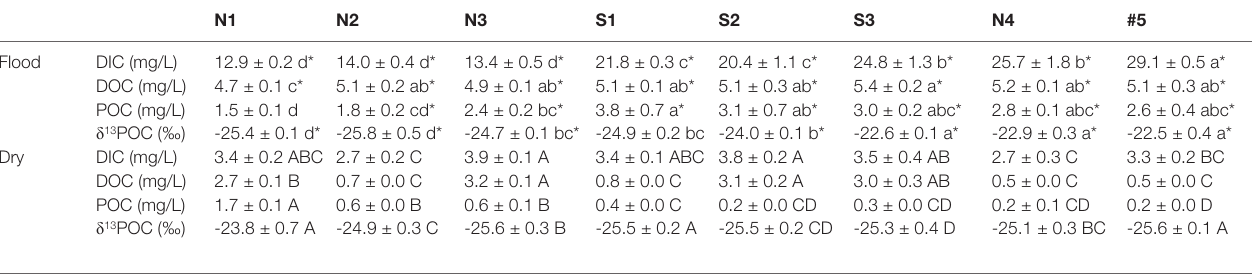
TABLE 3 | Statistics of significant difference in the flood and dry seasons (mean ± SE, the uppercase and lowercase letters indicate the spatial difference in the flood season and dry season, respectively, and * indicates the seasonal difference at the same station, the differences are significant at p< 0.05). N1 N2